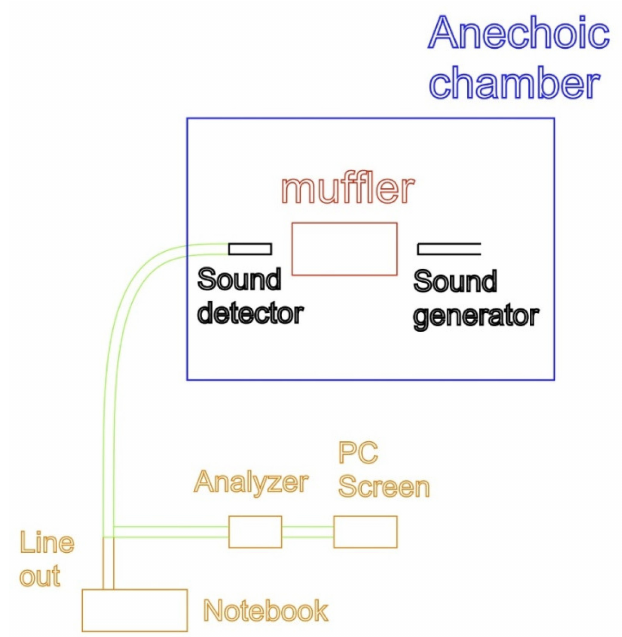
Figure 8. The experiment set up to retrieve sound.